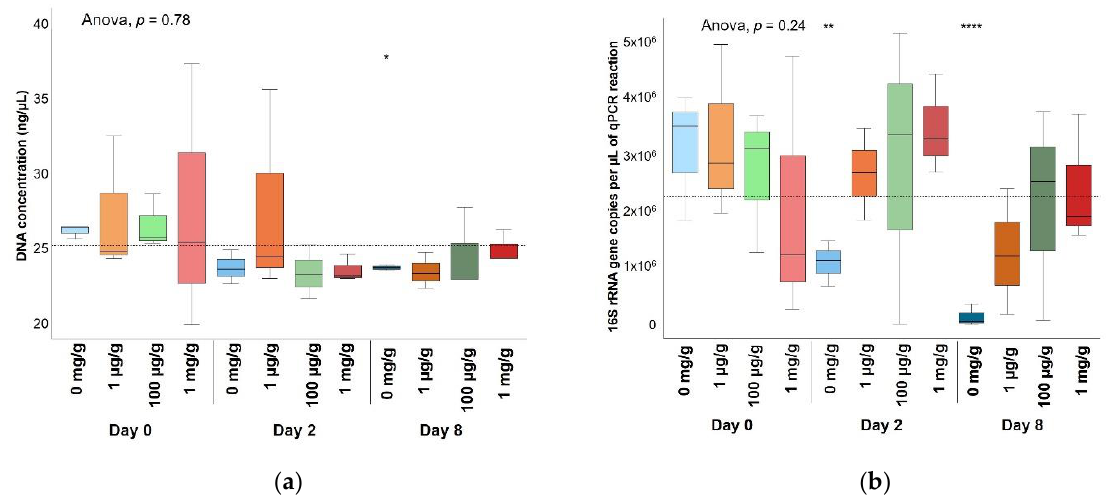
Figure 3. Bacterial dynamics over time in soil microcosms at different gentamicin concentrations. ( a ) DNA concentrations and ( b ) number of 16S rRNA gene copies/µL of qPCR reaction obtained from nonpolluted soil microcosms or microcosms polluted with gentamicin at 1 µg/g, 100 µg/g or 1 mg/g. Significant differences between each group (each concentration and each exposure time) and the average between all groups (horizontal line) were determined by a t-test. * p -value ≤ 0.05. ** p -value ≤ 0.01. **** p -value ≤ 0.0001. n = 3.